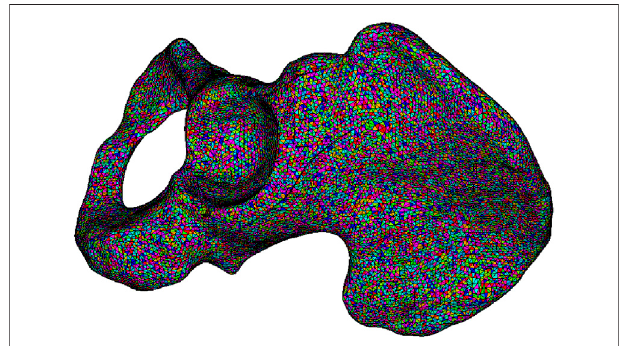
FIGURE 2 | Mesh model of the human left pelvis with heterogeneous material.